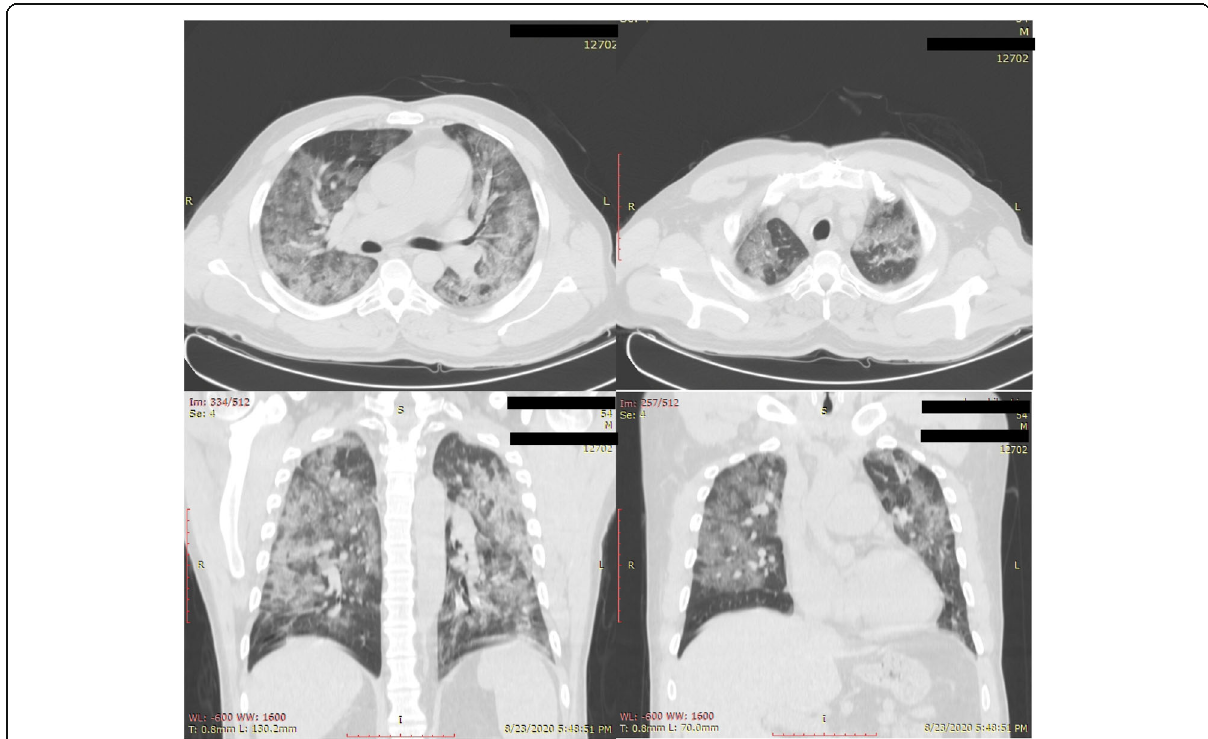
Fig. 4 Sixty-four-year-old male presented with cough. His PCR test was positive. CT chest is showing diffuse ground glass opacities with consolidative changes. There is associated vascular enlargement within the GG areas. Lung involvement is about 80%, i.e., CT severity score is